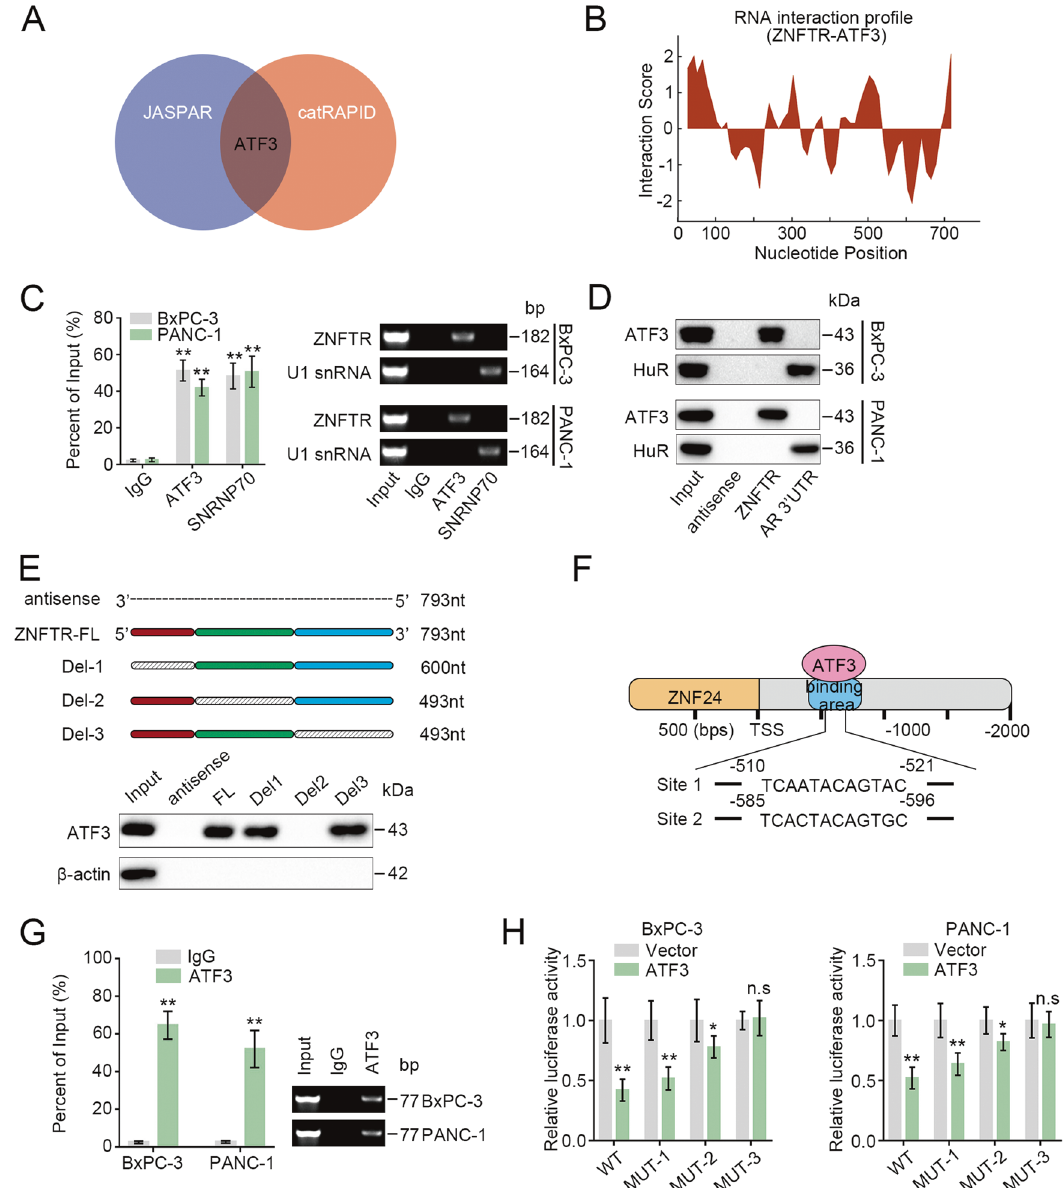
Fig. 3 ATF3 could interact with ZNFTR and the promoter of ZNF24. A ATF3 showed potential mutual interaction with ZNFTR and the promoter of ZNF24 through intersecting from the catRAPID and JASPAR database. B RNA interaction pro fi le showed the putative binding position between ZNFTR and ATF3. C RIP assay was performed to verify the interaction between ATF3 and ZNFTR with anti-ATF3 antibody in BxPC-3 and PANC-1 cells. The co-precipitated RNAs were detected by qRT-PCR. Anti-SNRNP70 rabbit polyclonal antibody co-precipitated with U1 snRNA was used as a positive control. The qRT-PCR products were separated by 2% agarose gel electrophoresis. D The RNA-pulldown assay was conducted to demonstrate the interaction between ATF3 and ZNFTR by biotinylated ZNFTR probe in BxPC-3/PANC-1 cells. Then the pulldown protein was detected by immunoblot assay with anti-ATF3 and anti-HuR antibody. RNA from the 3 ′ untranslated-region (UTR) of the androgen receptor (AR), involving UC-rich HuR binding areas, was used as a positive control. E Biotinylated ZNFTR full length, antisense, and part of it were conducted, and RNA-pulldown assay was performed to verify the region of ZNFTR interacted with ATF3. F The schematic diagram exhibited two predicted binding sites between ATF3 and promoter of ZNF24. G ChIP assay was conducted to verify the interaction between ATF3 and promoter of ZNF24. The qRT-PCR products were separated by 2% agarose gel electrophoresis. H The vectors containing the wild type (WT) or three mutants (MUT) of ATF3 binding sites were co-transfected with empty vector or pcDNA-ATF3 in BxPC-3 and PANC-1 cells to perform luciferase reporter assay. WT: wild type, MUT-1: Site1 mutated, MUT-2: Site2 mutated, MUT-3: Both Site1 and Site2 mutated. All data were revealed as means ± standard deviation (SD) for no less than three independent experiments. Signi fi cant P values showed as * P < 0.05 and ** P < 0.01. n.s means the difference was not signi fi abilities were distinctly enhanced under hypoxia conditions, which expression of VEGFA was increased under hypoxia conditions, which were dramatically reversed by overexpression of ZNFTR (Fig. S8E – G). was reversed by overexpression of ZNFTR (Fig. S8A – D). But the Moreover, rhVEGFA could rescue the impaired tube formative, expression of ATF3 had no signi fi cant change in hypoxia conditions migrative, and invasive abilities caused by overexpression of ZNFTR. (Fig. S8A, B). Coincidently, the tube formative, migrative, and invasive